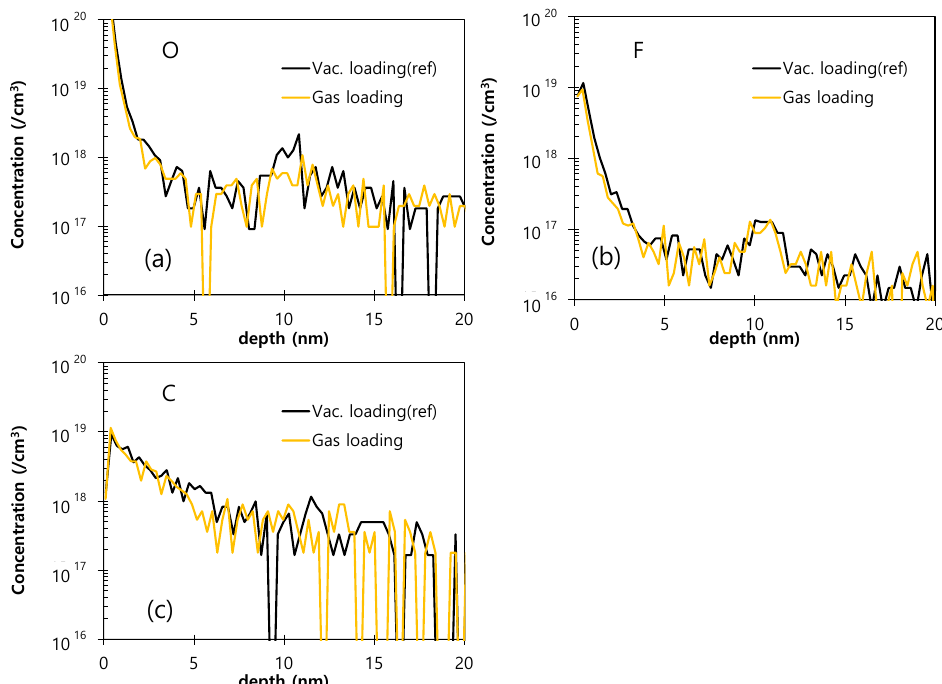
Figure 12. The SIMS O ( a ), F ( b ), and C ( c ) profiles of the Si epitaxial films obtained using different loading conditions (vacuum loading or gaseous loading), where all wafers were dry pre-cleaned.